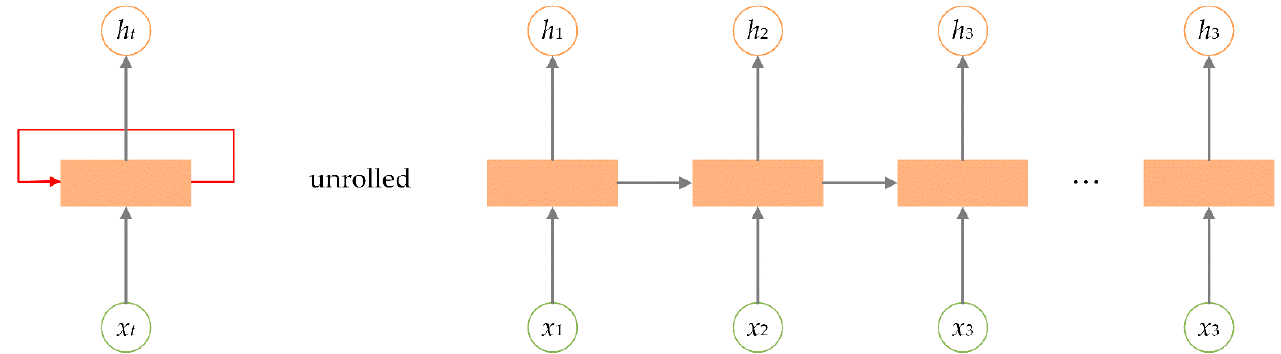
Figure 6. Recurrent neural network (RNN) architecture.